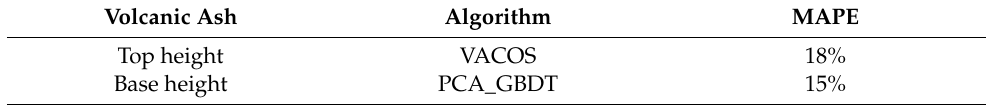
Table 6. Comparison of the retrievals of VACOS and PCA_GBDT against CALIOP data. Volcanic